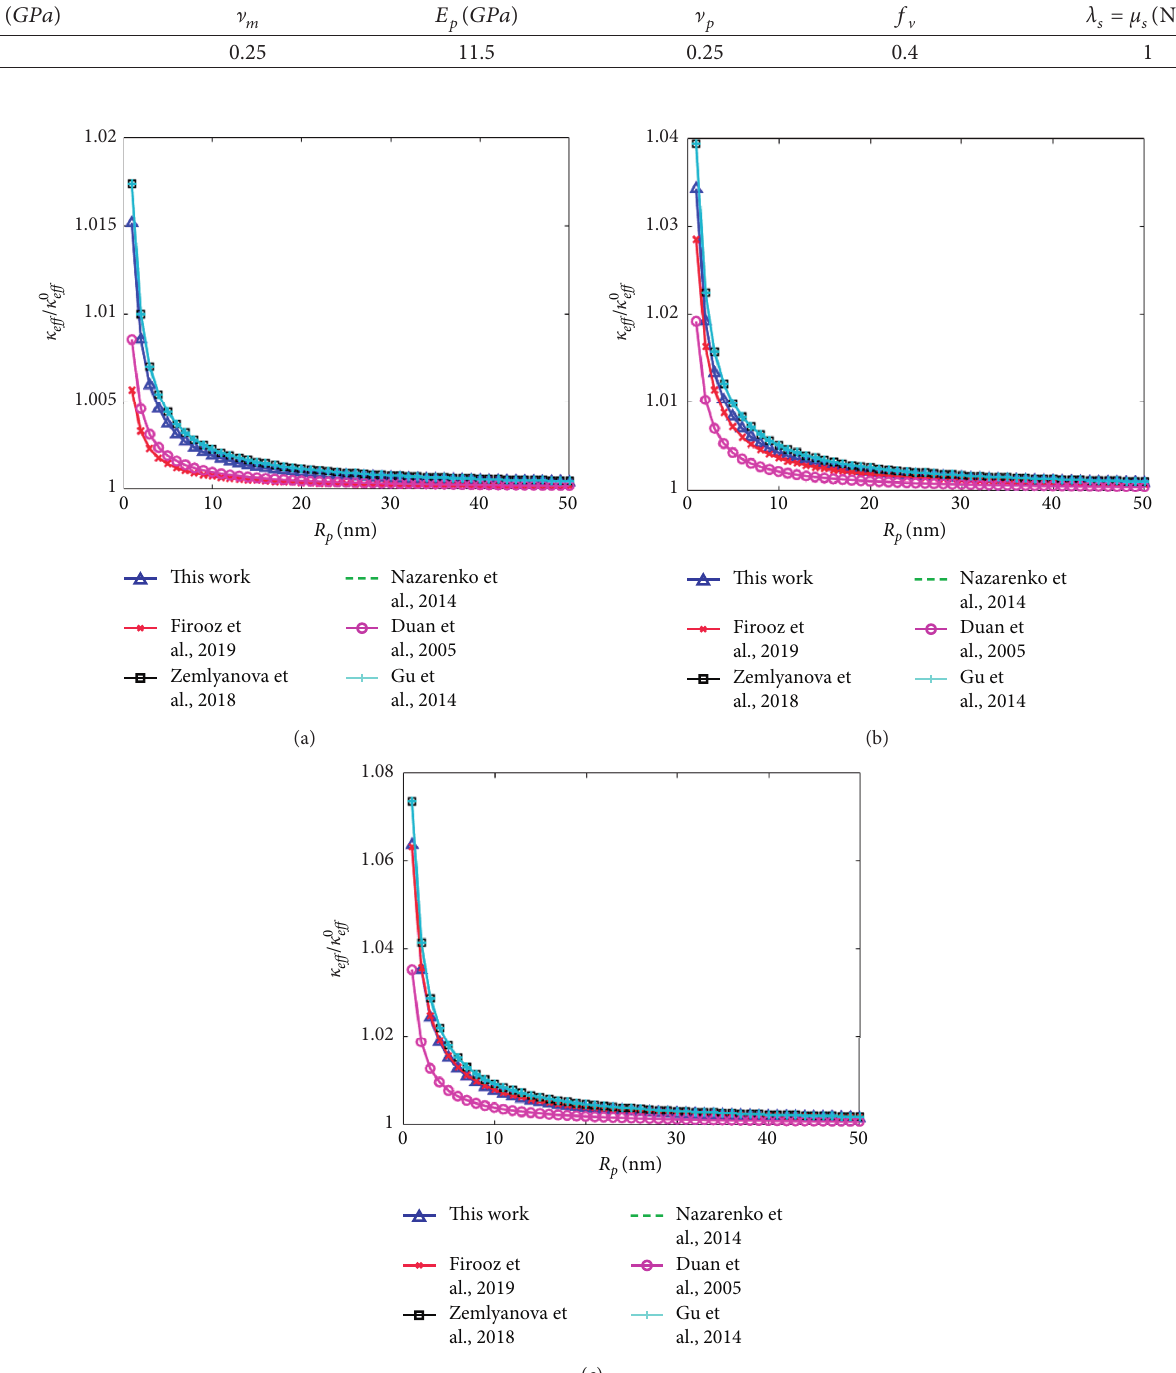
Figure 5: Comparison of effective bulk modulus ratio curves between 6 models, in function of nanoparticle radius, with (a) f 0.4, and (c) f v � 0.6, and E p / E m � 10.